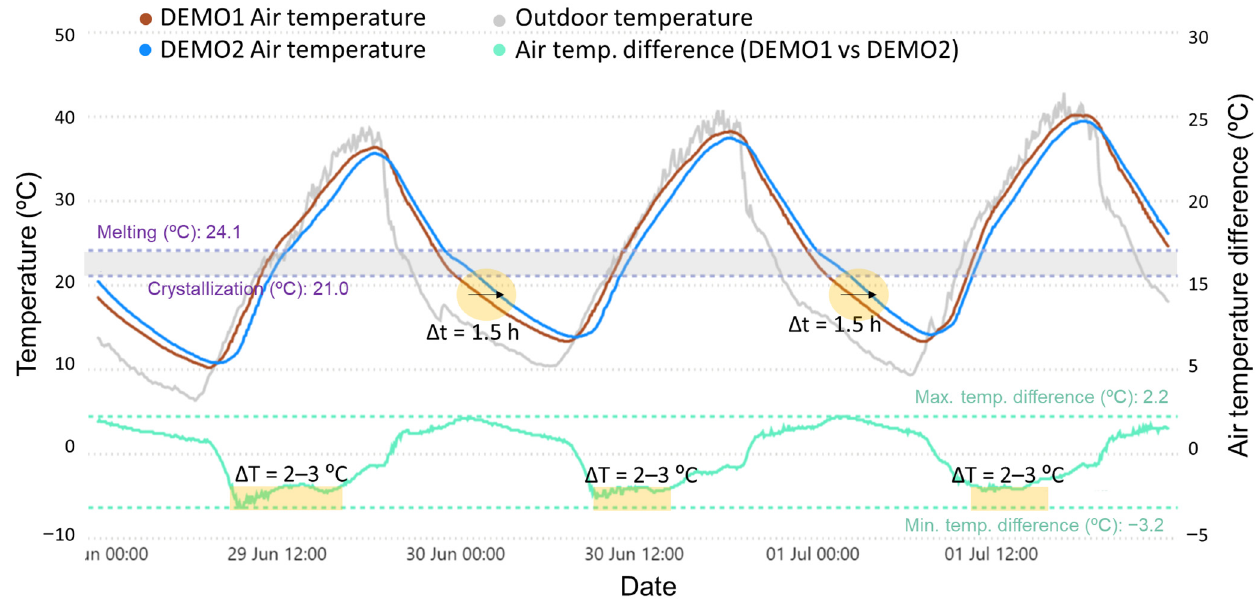
Figure 8. Comparison of room air temperature values at DEMO1 (reference cell without PCM) and DEMO 2 (test cell incorporating Micronal-based panels). Zoom on three consecutive days on the last week of June 2021. In light green, the room temperature difference between both cells is shown.